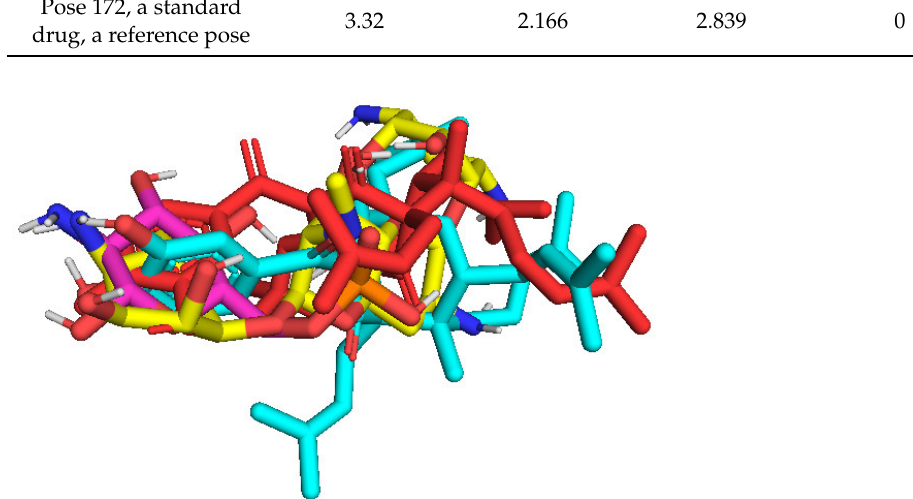
Figure 28. The best docking poses of the ligand, pose 158 (red), pose 35 (cyan), and pose 83 (violet) aligned to pose 172 (yellow).